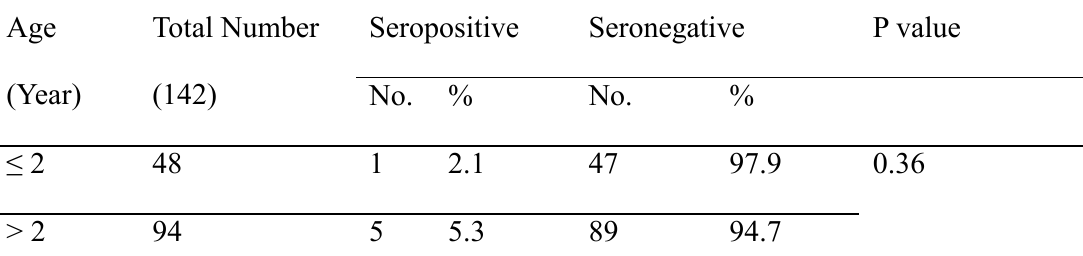
Table 3. The Seropositivity of Anti F. hepatica IgG Antibodies in Milk of Goats by ELISA according to the